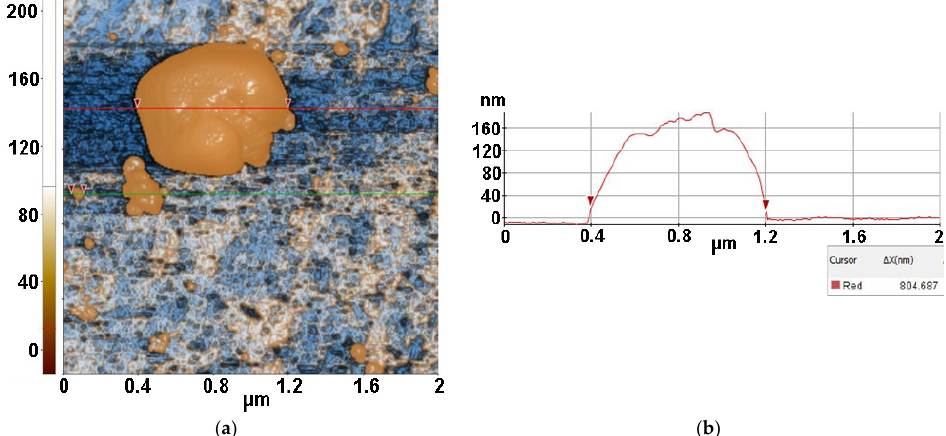
Figure 11. Two-dimensional AFM image of MC from inoculum with ZnSe-TiO 2 after 30 min of irradiation, deposited on glass substrate, recorded at the scale of 2 µ m × 2 µ m ( a ), together with a characteristic line scan ( b ).